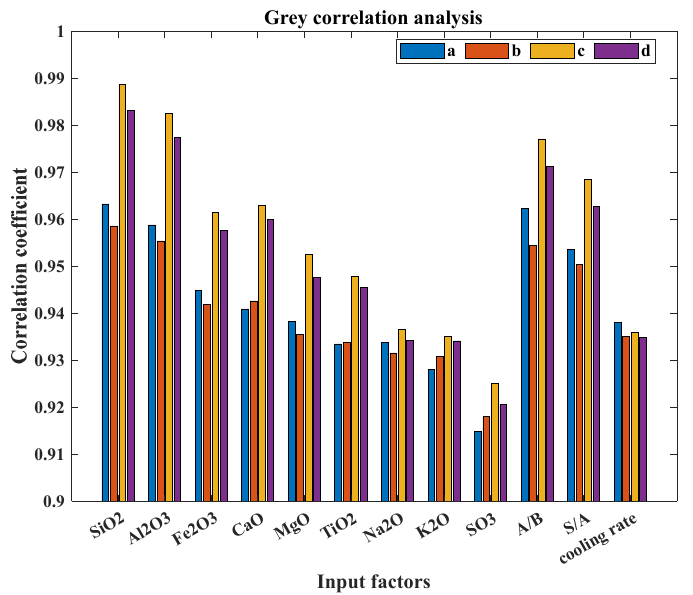
Figure 6. Grey correlation analysis results for the input variables and model parameters.